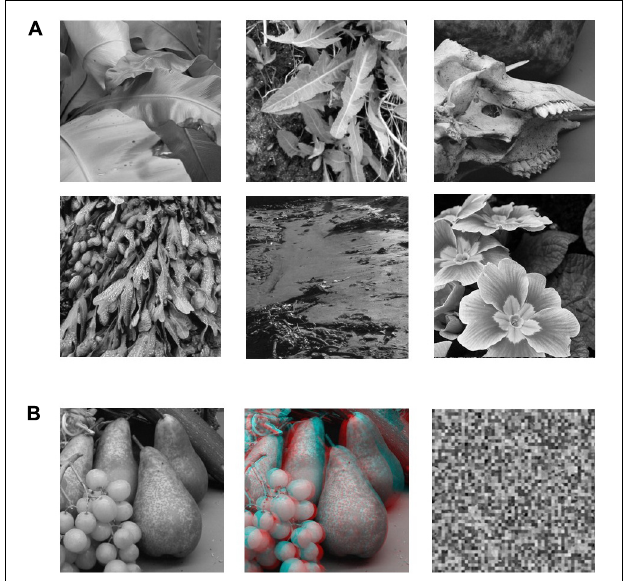
FIGURE 1 | (A) Sample of six of the 12 B&W photographic images used in the study. (B) Example of the three versions of each image that were used in the experiment. The leftmost image is the pictorial (no-disparity) version of the image (left-camera view only). The middle image is the stereoscopic (disparity) version of the image combining left and right camera views. The rightmost image is the scrambled version of the pictorial image (50 × 50 cells).